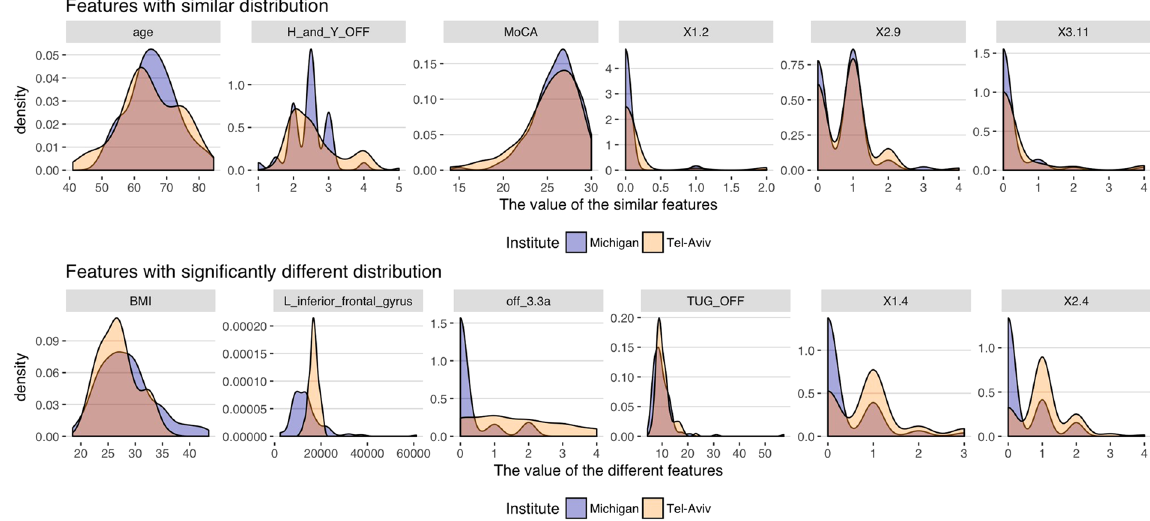
Figure 6. Similarities and differences between feature distributions in the Michigan and Tel-Aviv datasets.